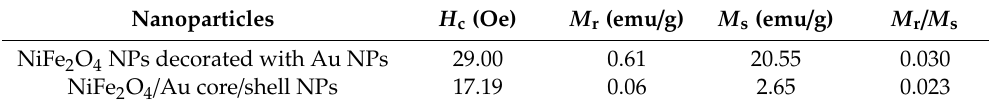
Table 2. Coercive field ( H c ), saturation magnetization ( M s ), remnant magnetization ( M r ), and ratio M r / M s for NiFe 2 O 4 /Au core/shell nanoparticles (NPs) and NiFe 2 O 4 NPs decorated with gold, at room temperature.